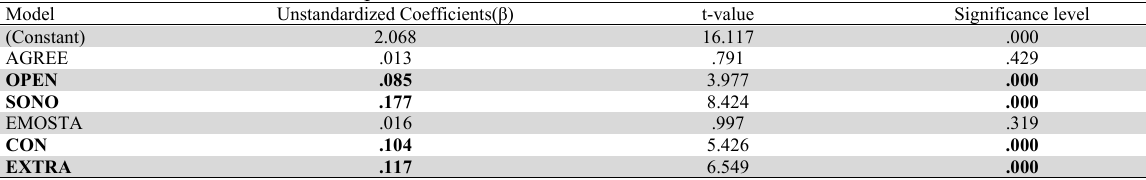
Table 5 Coefficients between NEGAT and independent variables Model